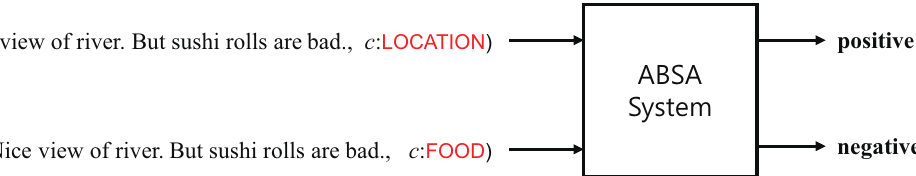
Figure 2. The description of the ABSA task with two different tuples from a single review